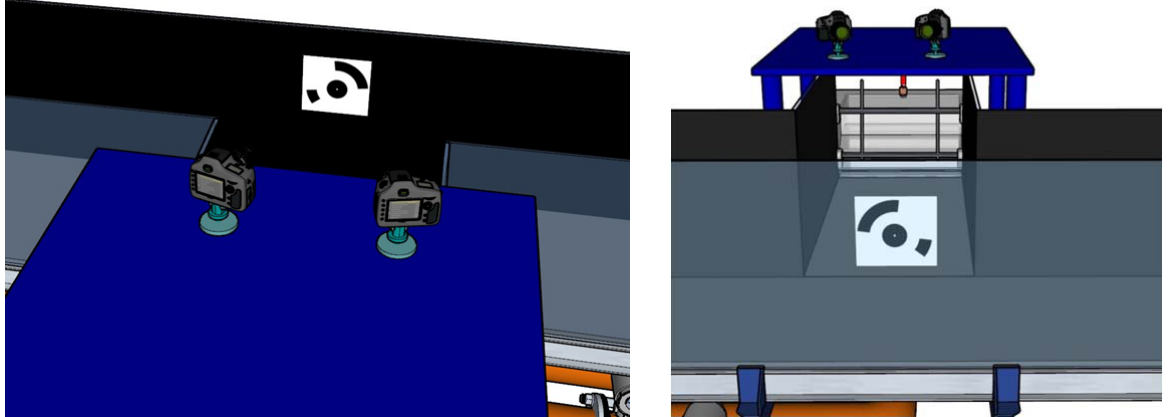
Figure 3. View of the placement of the cameras from the direction of the side stream (left) and opposite the side stream (right)